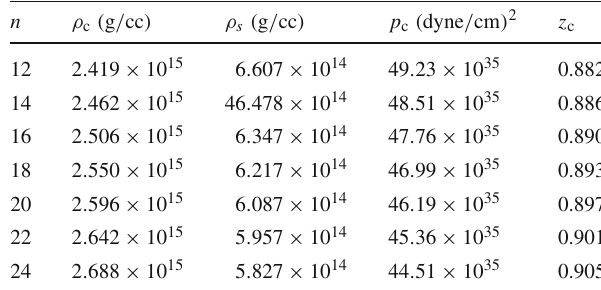
Table 2 Central values of some physical quantities for different values of